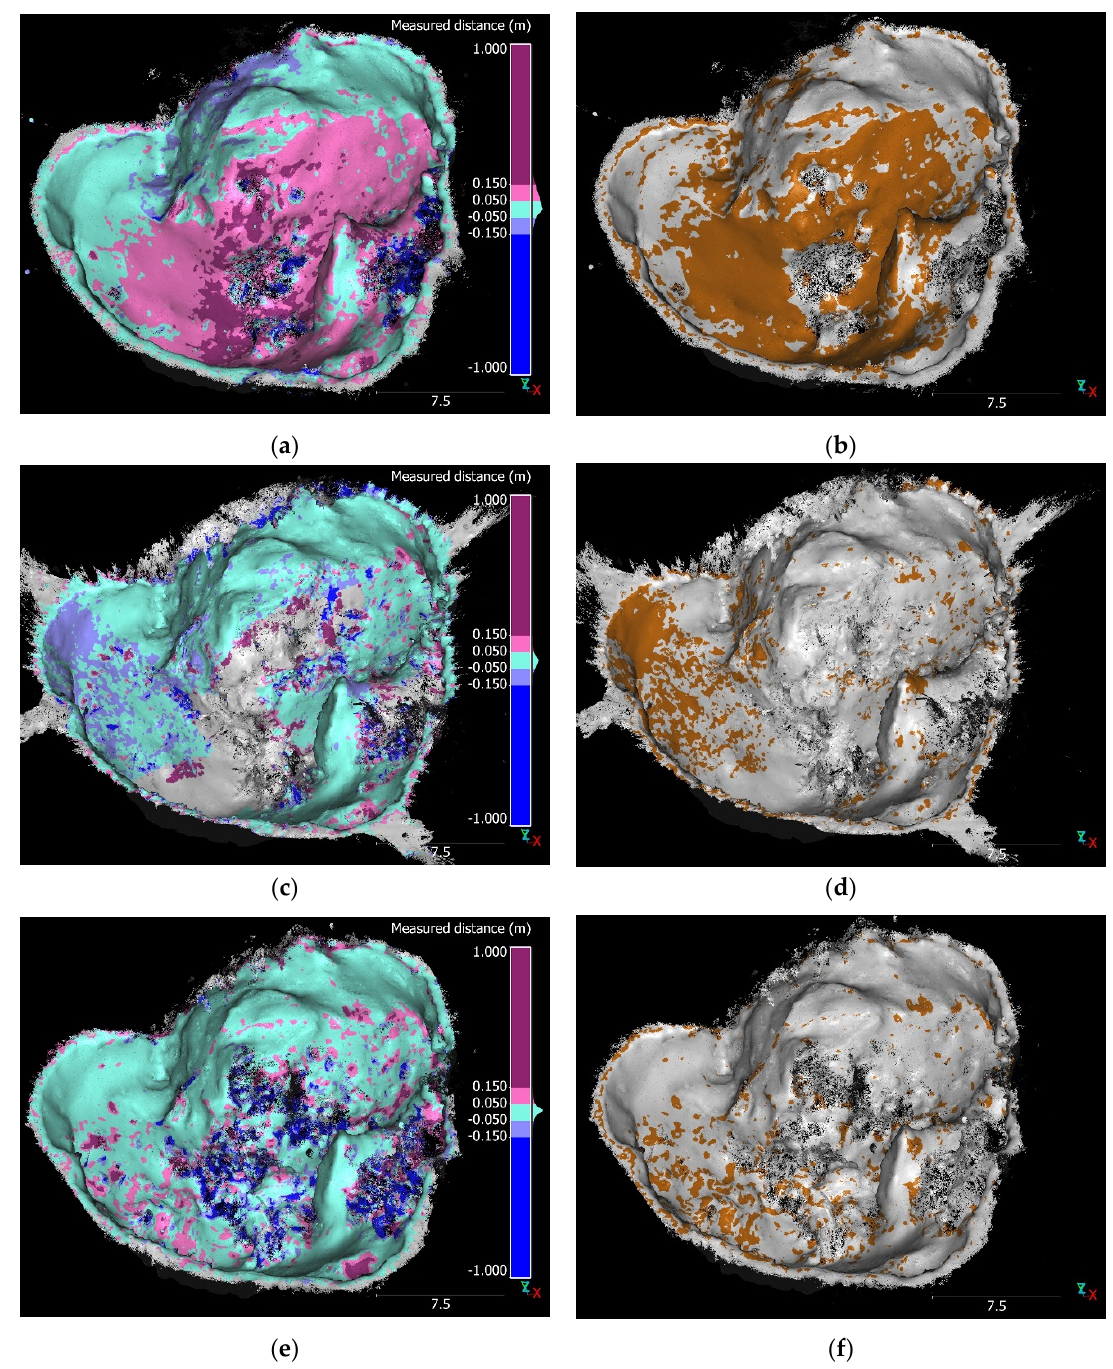
Figure 3. Measured distances and points with detectable change (brown) for comparisons of TerrUAV 2017, 2018, and 2019: ( a ) TerrUAV 2017 measured distance (m) between terrestrial and UAV point cloud 2017, displayed on the UAV point cloud. ( b ) TerrUAV 2017 detectable change between terrestrial and UAV point cloud 2017. ( c ) TerrUAV 2018 measured distance (m) between terrestrial and UAV point cloud 2018, displayed on the UAV point cloud. ( d ) TerrUAV 2018 detectable change between terrestrial and UAV point cloud 2018. ( e ) TerrUAV 2019 measured distance (m) between terrestrial and UAV point cloud 2019, displayed on the UAV point cloud. ( f ) TerrUAV 2019 detectable change between terrestrial and UAV point cloud 2019. Note the different information portrayed by the color gray: in ( a , c , e ), gray areas show areas where no change was measured due to missing points in one of the point clouds; in ( b , d , f ), the gray color shows points with no detectable change.